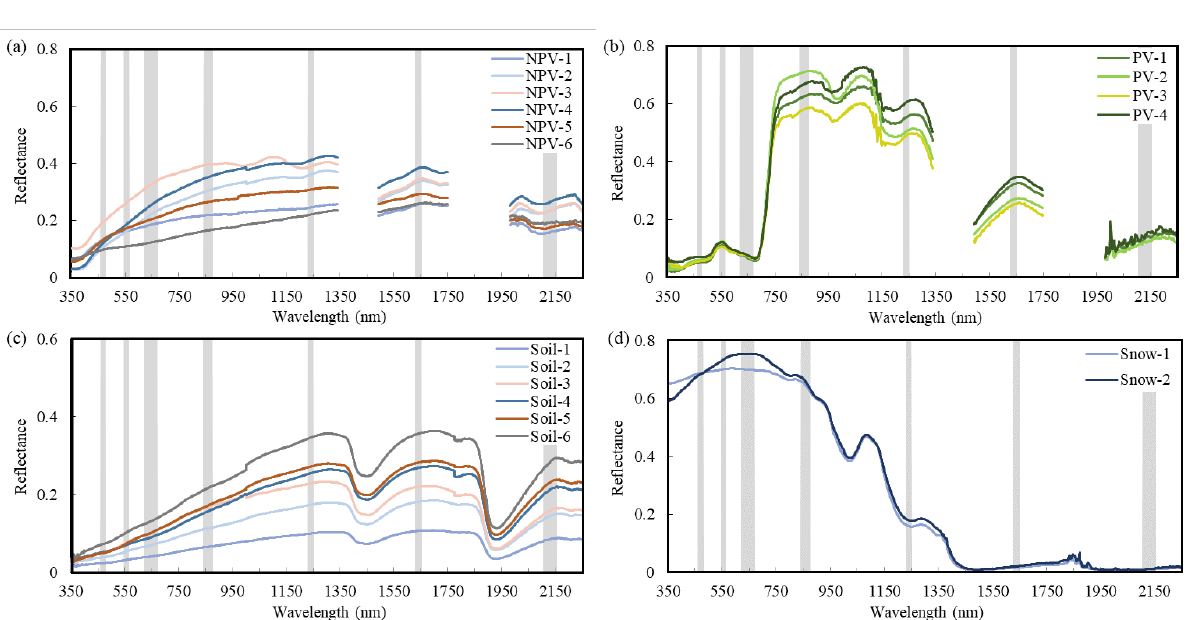
Fig.2 Reflectance spectra of (a) NPV, the wavelength ranges of MODIS bands are located by grey columns; (b)PV, (c)soil and